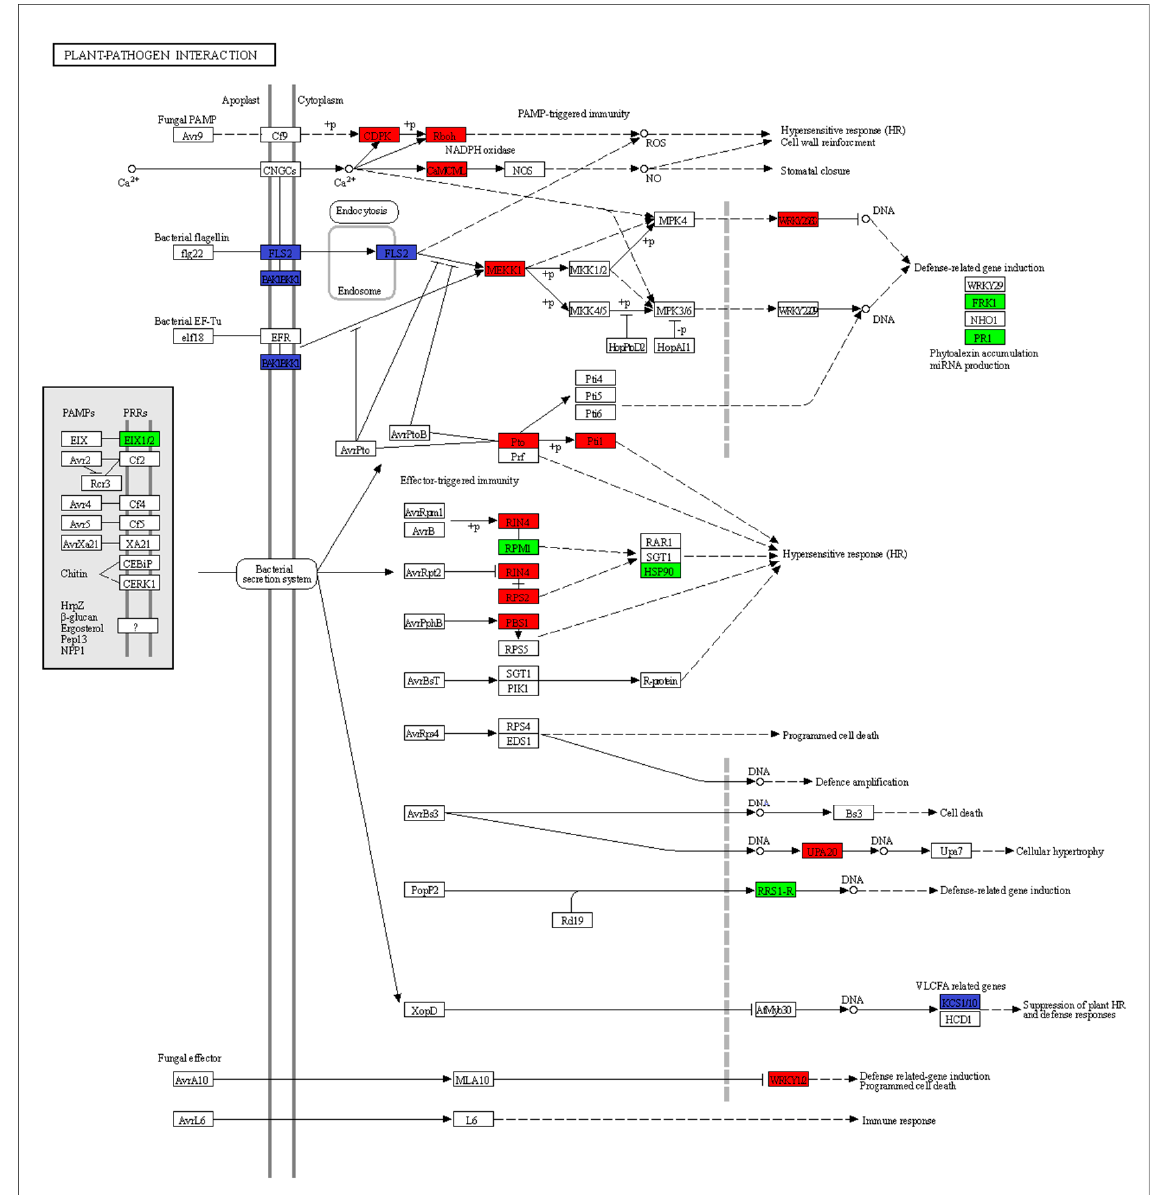
Figure 6. Differentially expressed genes are involved in plant–pathogen interactions. Expression values of the DEGs are presented as log 2 Fold Change > 1 (red for upregulated, green for downregulated, blue for both upregulated and downregulated).